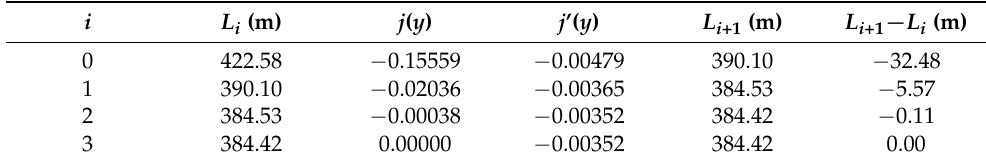
Table 1. Application using the Newton–Raphson